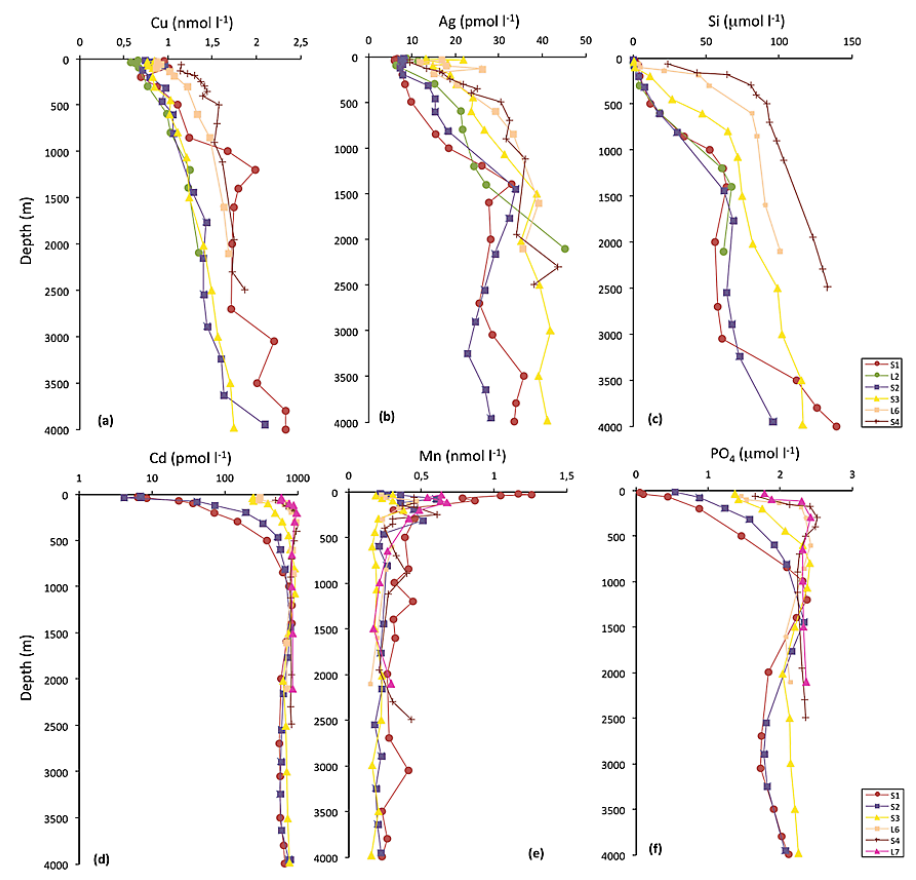
Fig. 4. Vertical distributions of dissolved copper (a) and silver (b) , silicic acid (c) , dissolved cadmium (d) , manganese (e) , and phosphate (f) at selected L and S stations (the data of major nutrients are from Le Moigne et al., 2012).